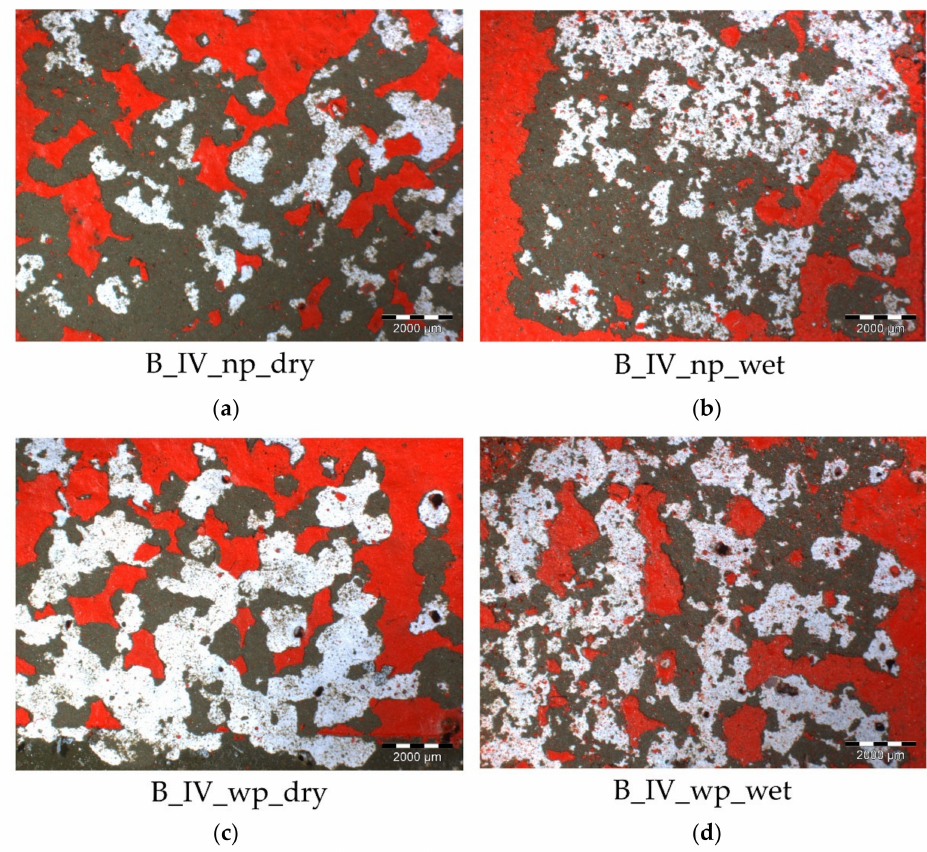
Figure 6. Optical images at 10 × of mock-up Btreated with laser cleaning with fluence approximately 0.78 J / cm 2 on dry surface ( a , c ) and with fluence approximately 1.35 J / cm 2 on wet surface ( b , d ), both on unprotected (np) and protected (wp) areas. ( a ) B_IV_np_dry; ( b ) B_IV_wet; ( c ) B_IV_wp_dry; ( d )